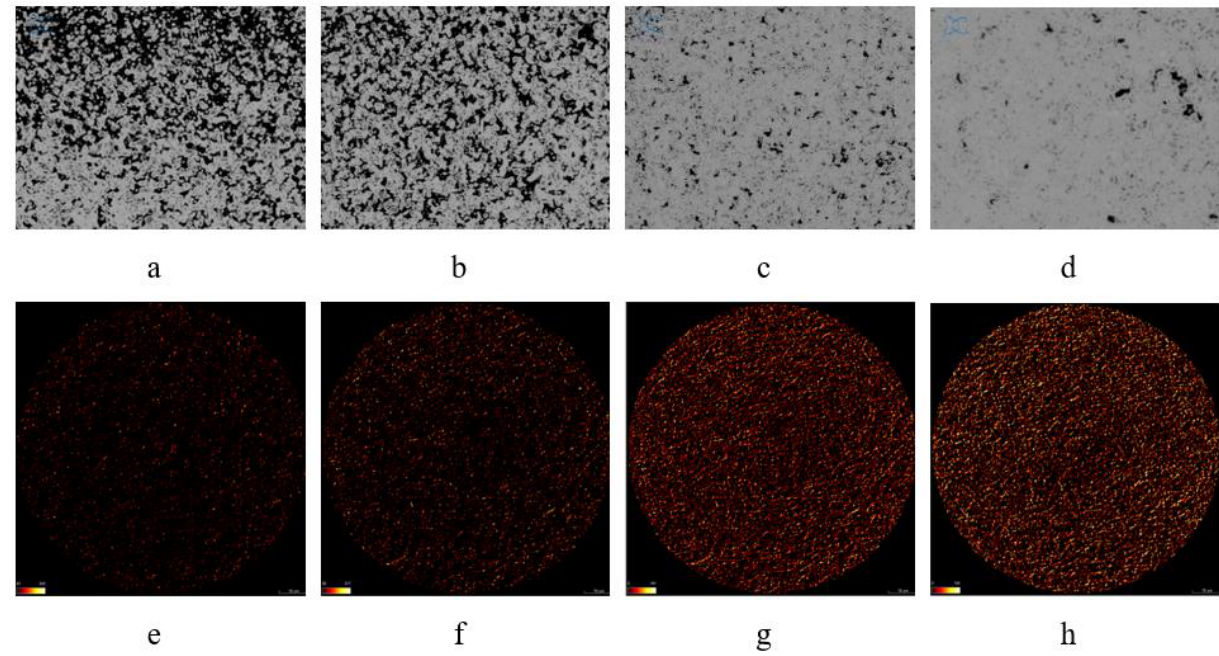
Figure 3. Micro-CT images (70 µm voxel size) of polyurea-polyurethane-MWCNTs nanocomposites comprising: ( a , e ) 0.05 wt.% MWCNTs, ( b , f ) 0.1 wt.% MWCNTs, ( c , g ) 0.2 wt.% MWCNTs, ( d , h ) 0.3 wt.% MWCNTs.